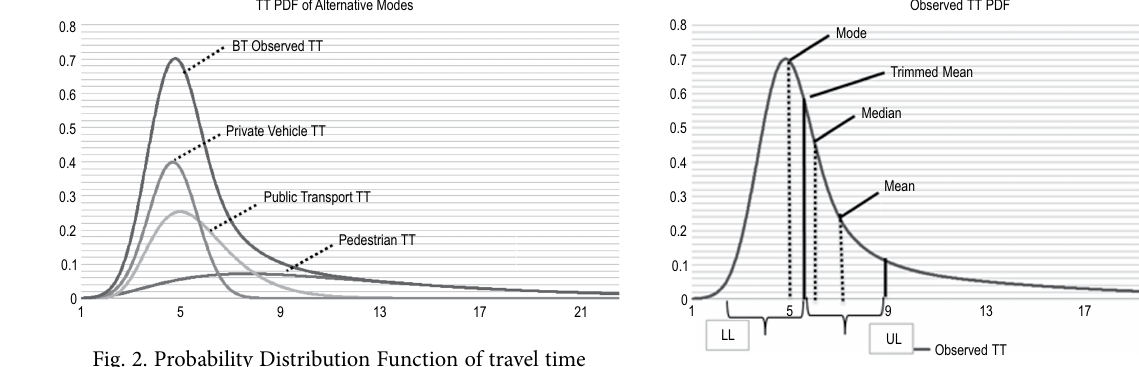
Fig. 3. Probability Distribution Function of travel time and various estimators